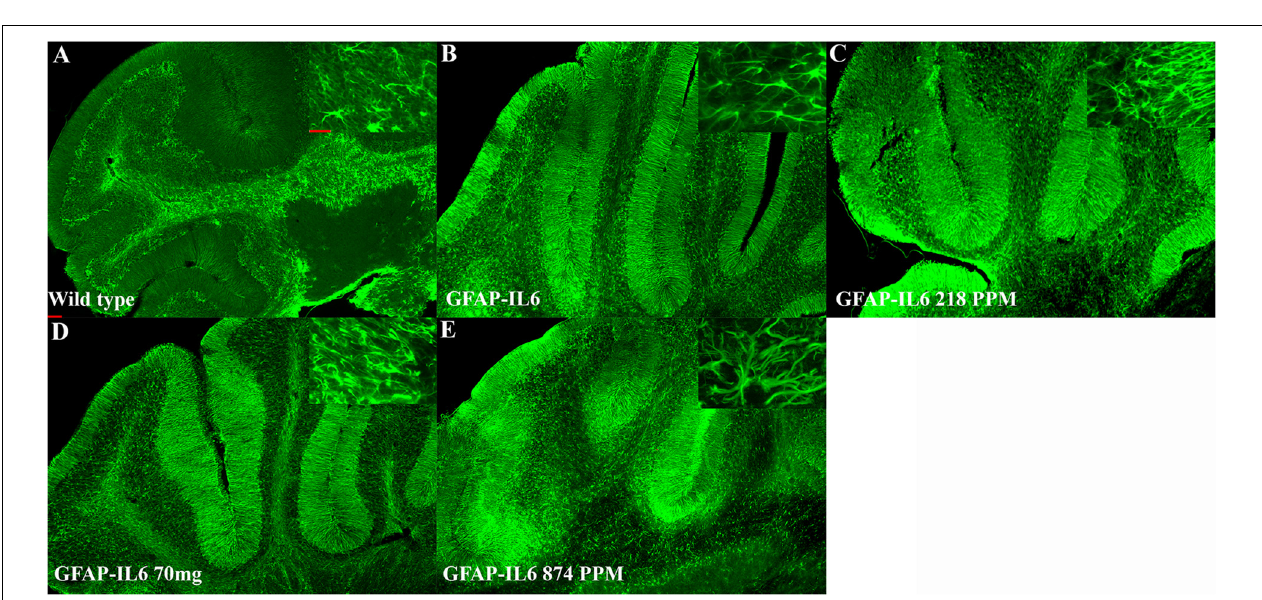
FIGURE 5 | MC decreased GFAP + astrocytes in the hippocampus of GFAP-IL-6 mice. (A) Representative photomicrographs of immunofluorescence staining for the astrocytes (GFAP + cells) in the hippocampus. (Magnification 5x and 63x objective field, scale bar = 100 µ m in 5x and 50 µ m in 63x). Images are representative of at least six animals per group ( n = 6). (B–F) Graphical representation of total GFAP count in the hippocampus. The graph represents the mean ± SEM and significant differences were determined using one-way analysis of variance (ANOVA). Significance = * p < 0.05, ** p < 0.001, *** p < 0.0001, **** p < 0.0001.